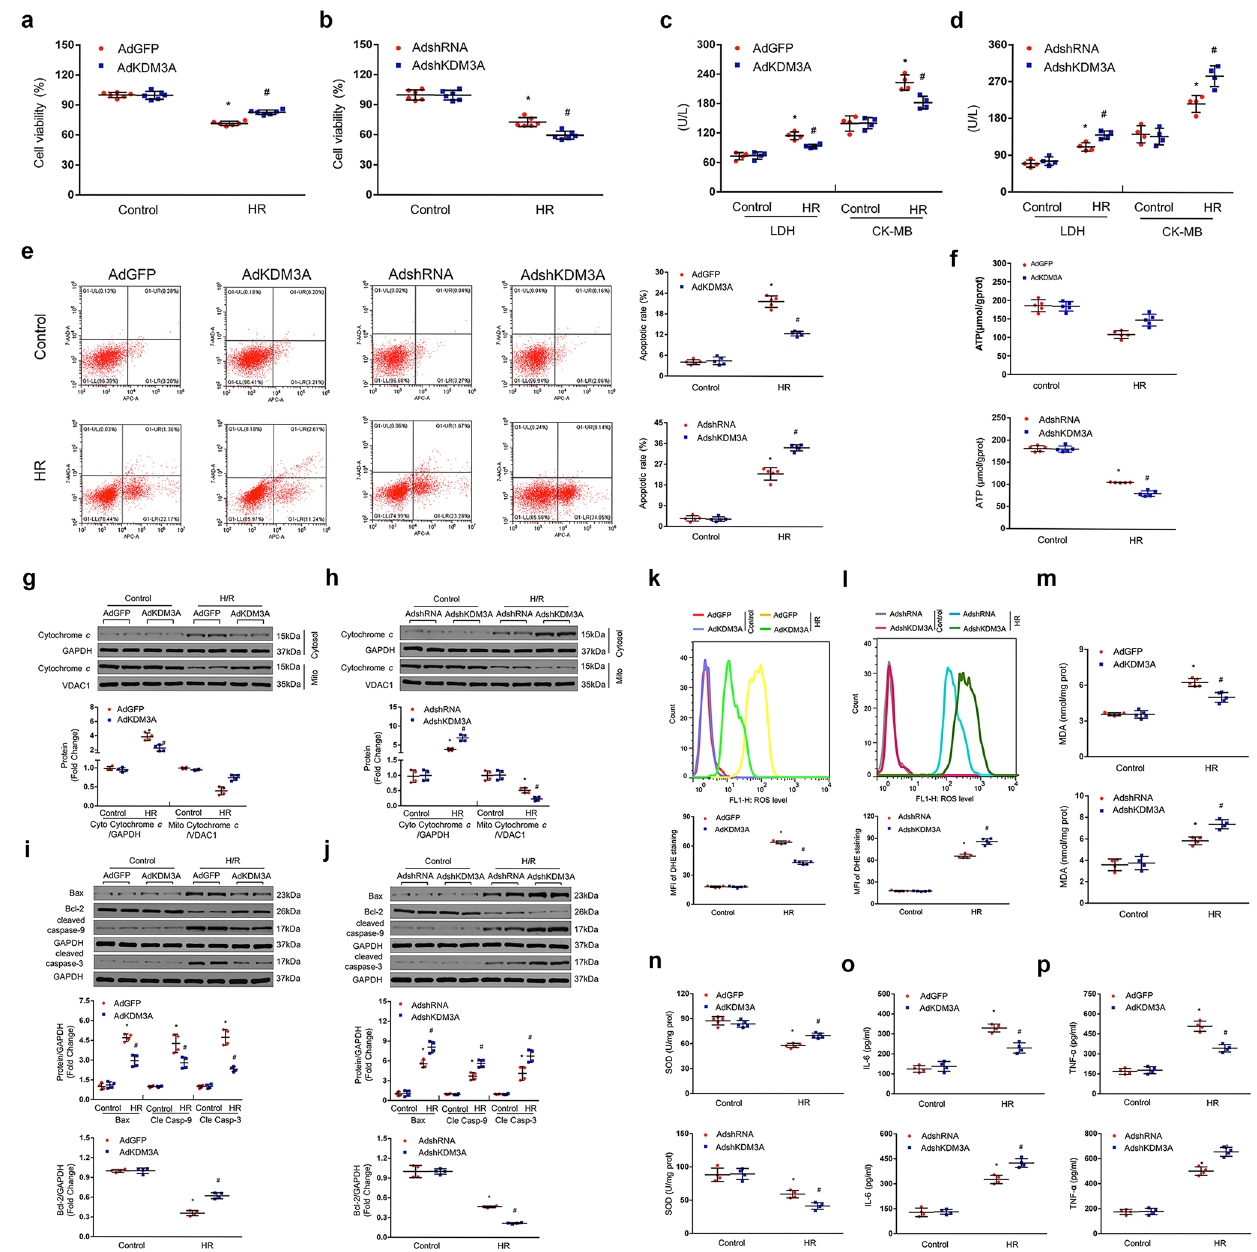
Fig. 6 The effects of KDM3A on H/R-exposed cardiomyocytes in vitro. Cell viability analysed by MTT ( a , b ) and culture medium LDH/CK-MB concentration ( c , d ). n = 6 per group, * P < 0.05 vs. AdGFP or AdshRNA/Control; # P < 0.05 vs. AdGFP or AdshRNA/H/R. e Representative images (upper panel) and quantitative results (lower panel) of apoptotic cardiomyocytes (detected by fl ow cytometry assay) infected with AdKDM3A or AdshKDM3A in response to H/R or control ( n = 5). f ATP production in NRCMs infected with AdKDM3A or AdshKDM3A either exposed to H/R or not ( n = 5). g – j Western blotting assay showing the levels of cytoplasmic cytochrome c , mitochondrial cytochrome c ( g , h ) Bax, Bcl-2 and cleaved caspase-9/3 ( i , j ) in primary cardiomyocytes infected with AdKDM3A or AdshKDM3A with or without H/R injury ( n = 4). Upper panel: representative bots; lower panel: quantitative analysis. * P < 0.05 vs. AdGFP or AdshRNA/Control; # P < 0.05 vs. AdGFP or AdshRNA/H/R. k , l ROS accumulation detected by DHE staining and fl ow cytometry (upper panel) and quanti fi ed MFI (lower panel) in NRCMs ( n = 5). m , n Levels of pro-oxidative MDA and antioxidative SOD in NRCMs ( n = 4-5). o , p Quanti fi cation of proin fl ammatory cytokines (IL-6 and TNF- α ) in AdKDM3A-/AdshKDM3A-infected cardiomyocytes either exposed to H/R or not ( n = 4). * P < 0.05 vs. AdGFP or AdshRNA/Control; # P < 0.05 vs. AdGFP or